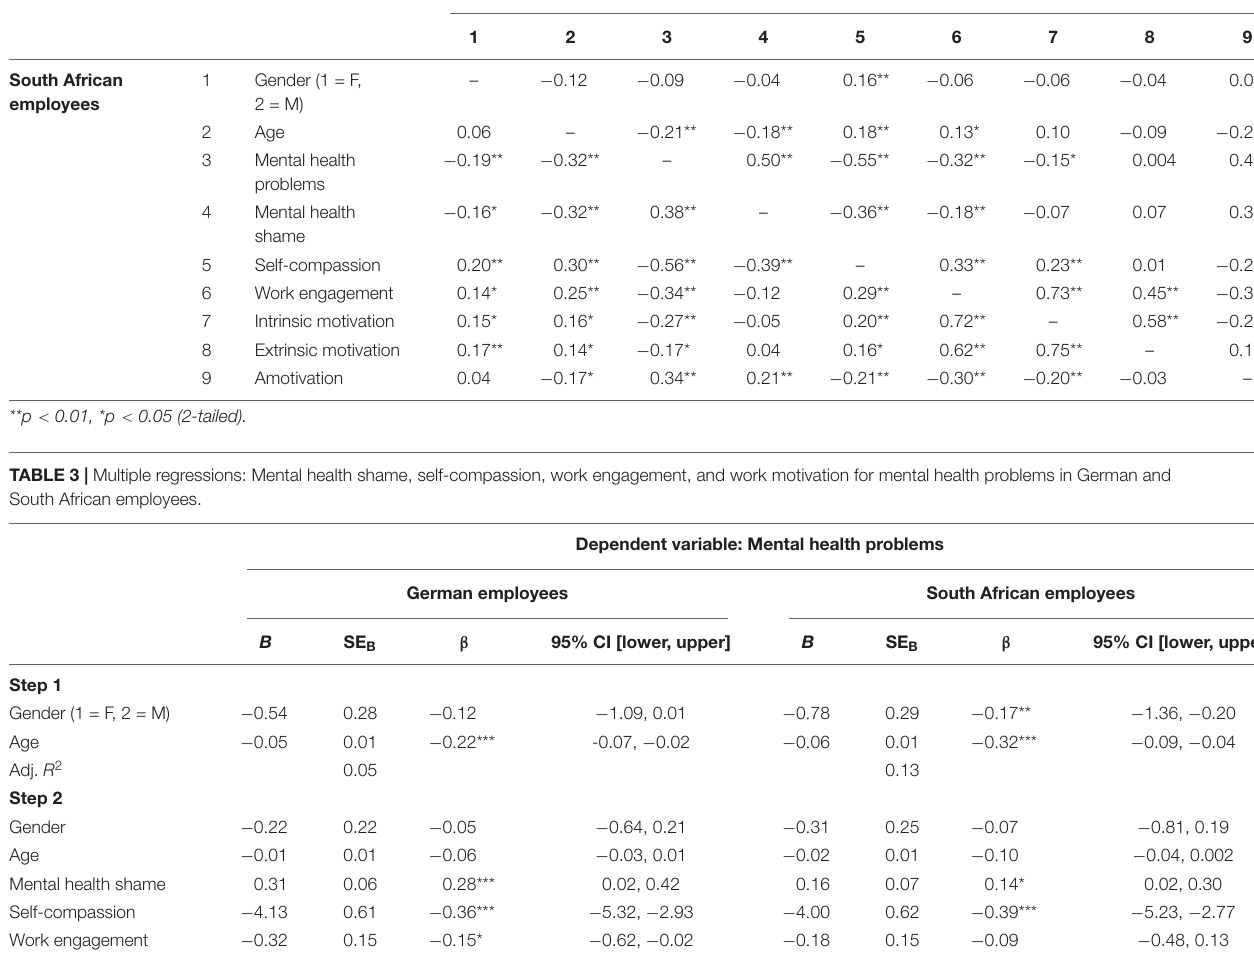
German employees